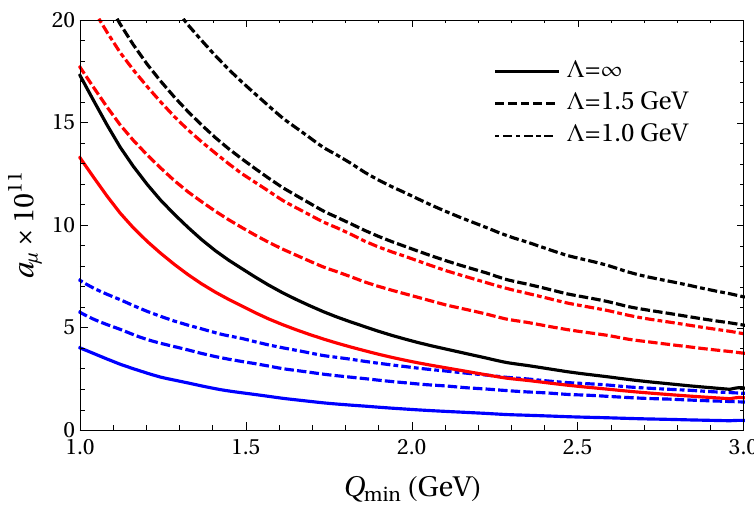
Figure 13. Contribution of the pQCD quark loop (with vanishing quark mass) to a (cid:22) from the region Q 1 ; 2 (cid:21) Q min with the contribution from Q 3 below Q min damped by Q 2 crossed). The total contribution from (cid:22)(cid:5) 1{12 is shown in black, together with the partial ones from (cid:22)(cid:5) 1{2 (red) and (cid:22)(cid:5) 3{12 (blue). The pQCD contribution with common lower cuto(cid:11) in all Q i is reproduced in the limit (cid:3) ! 1